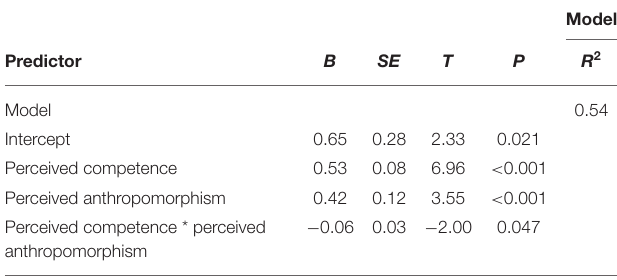
TABLE 5 | Moderated regression analysis testing the effect of perceived competence on attributed trustworthiness moderated by perceived anthropomorphism within study